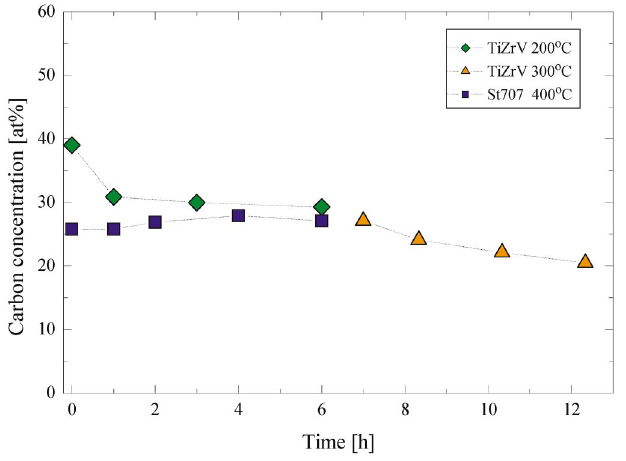
FIG. 10. (Color) Oxygen surface concentration of TiZrV and St707 during a bakeout in